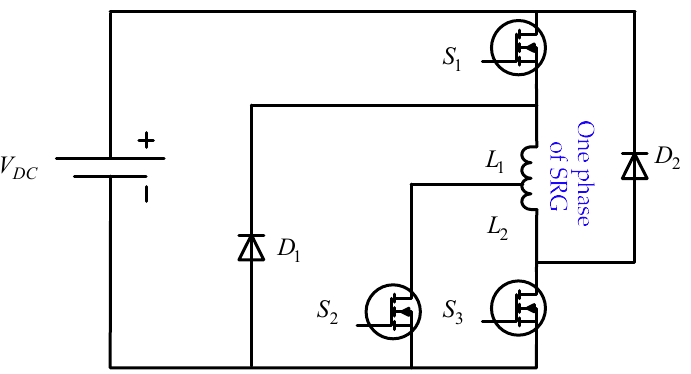
Figure 13. Dong converter topology of a SRG.